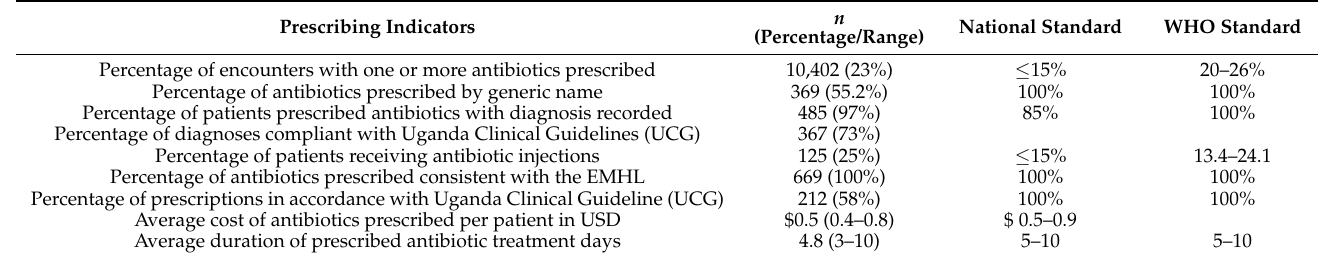
Table 3. Showing results for prescribing indicators.